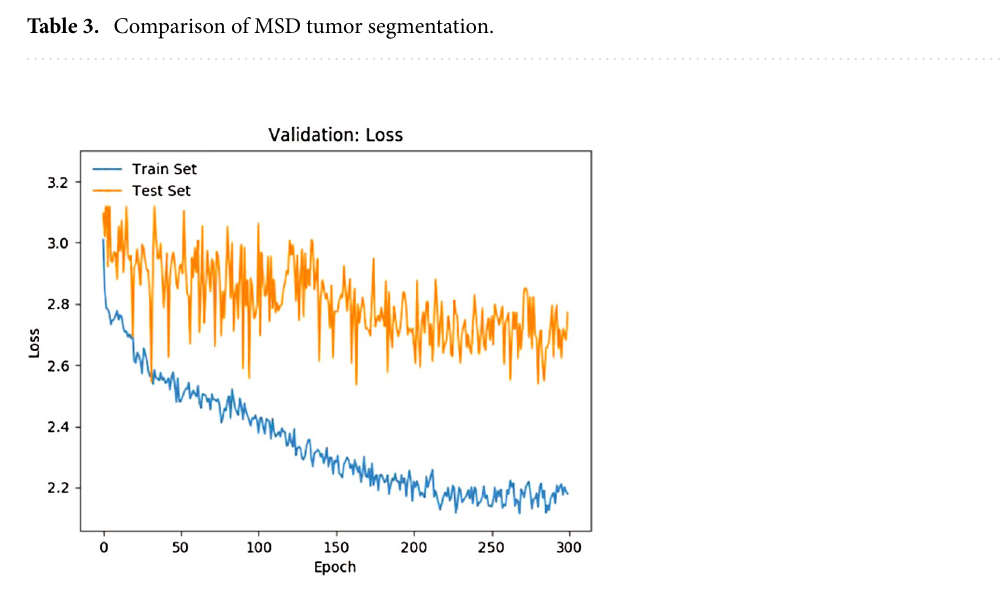
Figure 1. Loss function for training and